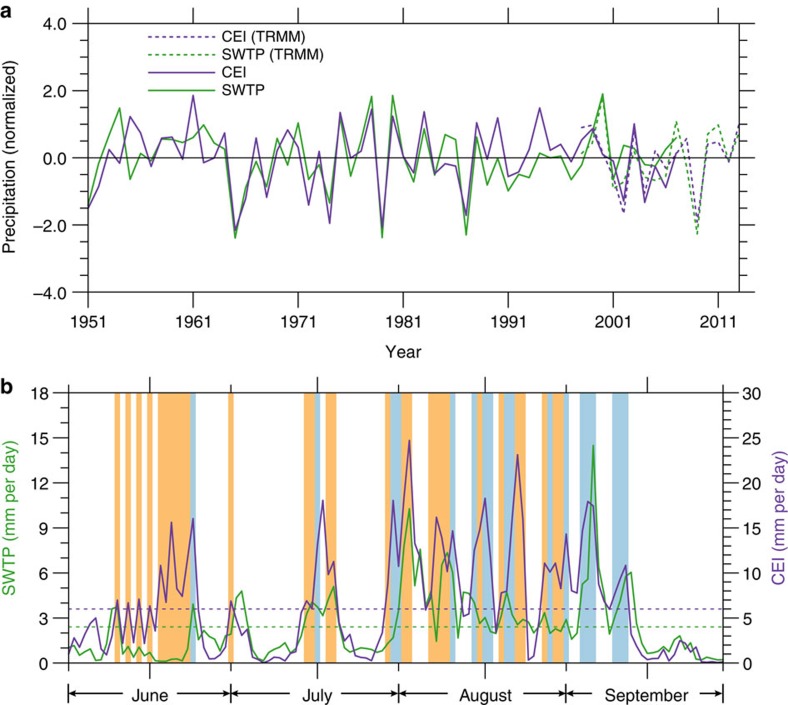
Summer precipitation variations.(a) Time series of standardized anomalies in summer mean precipitation over the southwestern Tibetan Plateau (SWTP; green) and central-eastern India (CEI; purple) using APHRODITE (1951–2007) and TRMM (1998–2013). (b) As in a but for daily precipitation from TRMM during June–September 2002. The light blue shading marks days with intrusive CSs, while the light orange shading marks days with non-intrusive CSs. Green dashed lines indicate the seasonal mean precipitation over the SWTP and purple for 6 mm per day over CEI.